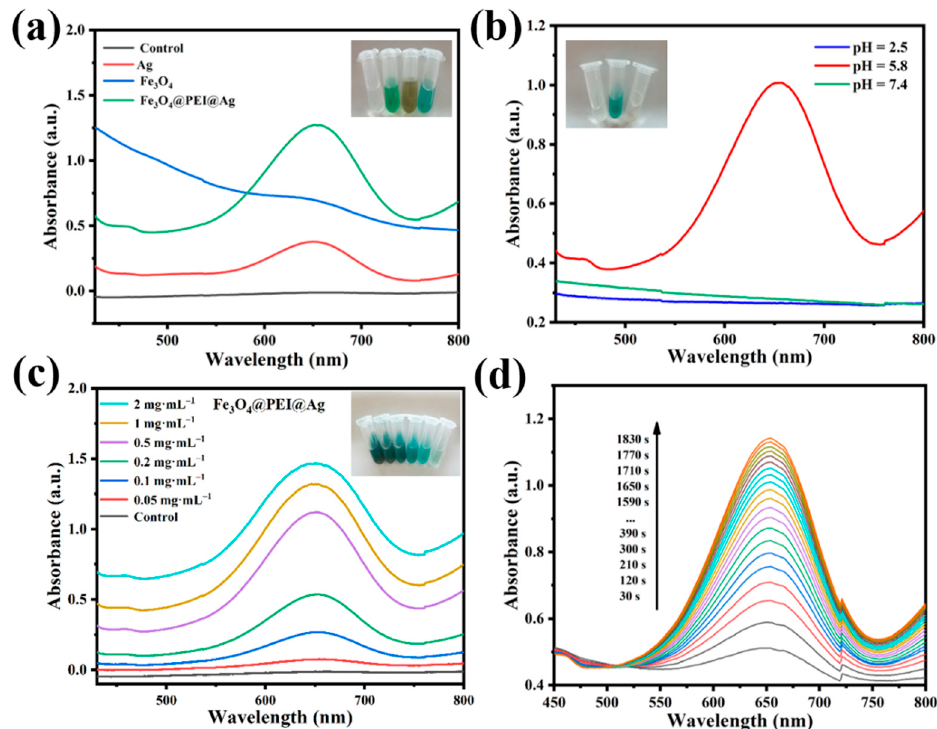
Figure 3. ( a ) UV-vis spectra and digital images (inset) of TMB catalyzed by the Fe 3 O 4 , Ag,